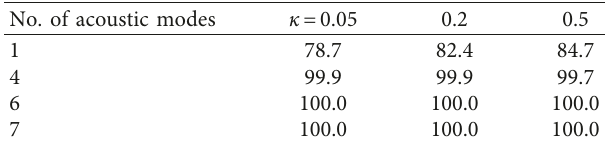
Table 1: (1,1) mode peak vibration amplitude convergence for various excitation magnitudes (3 symmetric structural modes, ζ � 0.02).